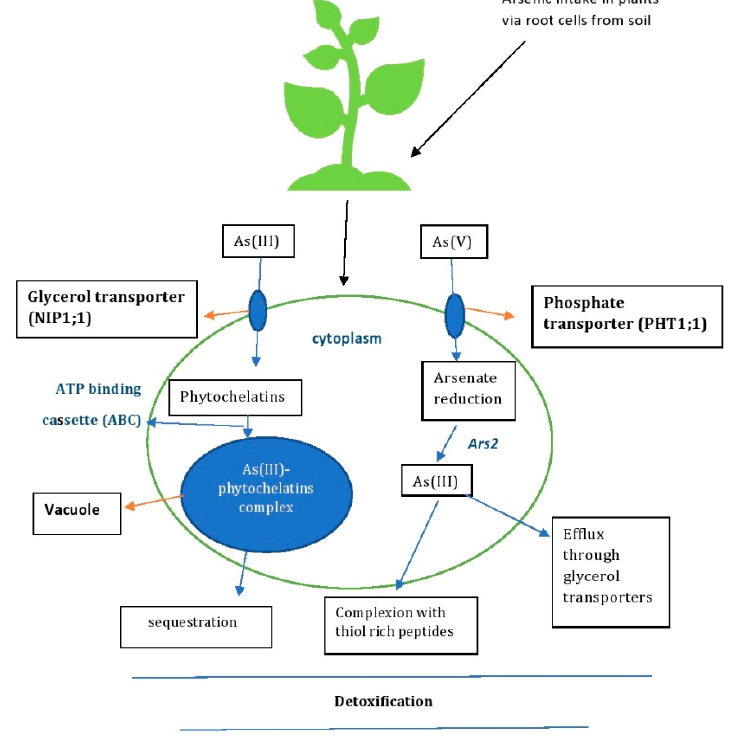
Figure 5. Mechanisms of As detoxification by plants—phytoremediation. Table 2. Arsenic-hyperaccumulating plant